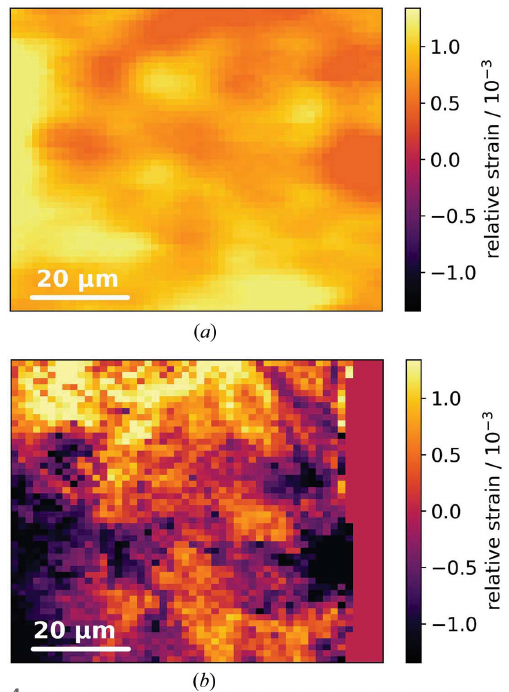
Figure 4 Relative strain maps in the [200] direction of two martensitic steel samples with a shot-peening Almen intensity of ( a ) 0.16 mm and ( b ) 0.3 mm. The images share the same colormap. The flat region on the right-hand side in ( b ) is out of the